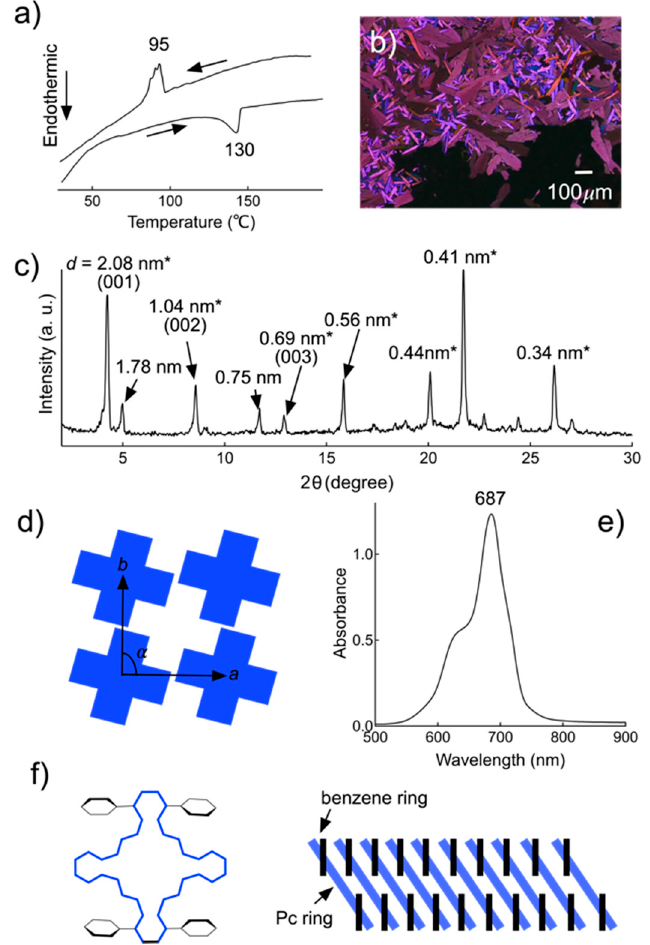
Figure 8. ( a ) DSC thermogram of 2 film during the first cooling and the second heating scans at 2 °C/min. ( b ) POM image of 2 at 93 °C cooling from 130 °C at 2 °C/min. ( c ) XRD pattern of 2 film at room temperature prepared by slow cooling from isotropic liquid at 2 °C/min. * shows diffraction peaks for one monoclinic lattice (a = 2.31 nm, b = 2.06nm, c = 0.41nm, α = 94°, β = γ = 90°). The other set of peaks can be indexed to a monoclinic lattice having different lattice constant (a = 1.81 nm, b = 1.77 nm, c = 0.83 nm, α = 93°, β = γ = 90°). ( d ) Schematic representation of the proposed structure of the crystalline phase of 2 from the view along the molecular xy-axis. ( e ) Absorption spectrum of 2 film at room temperature prepared by slow cooling from isotropic liquid at 2 °C/min. ( f ) Schematic